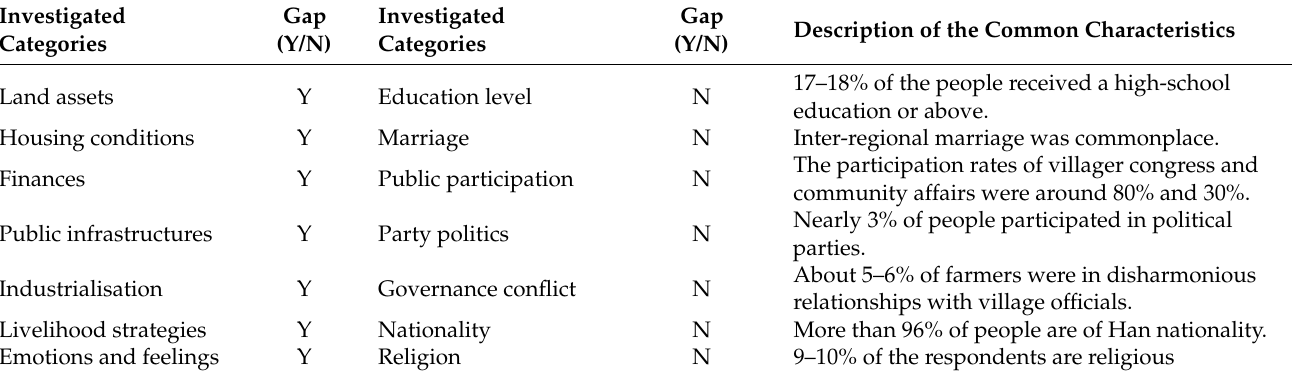
Table 2. Differentiated and common characteristics between the distant-resettlees and the stayers.